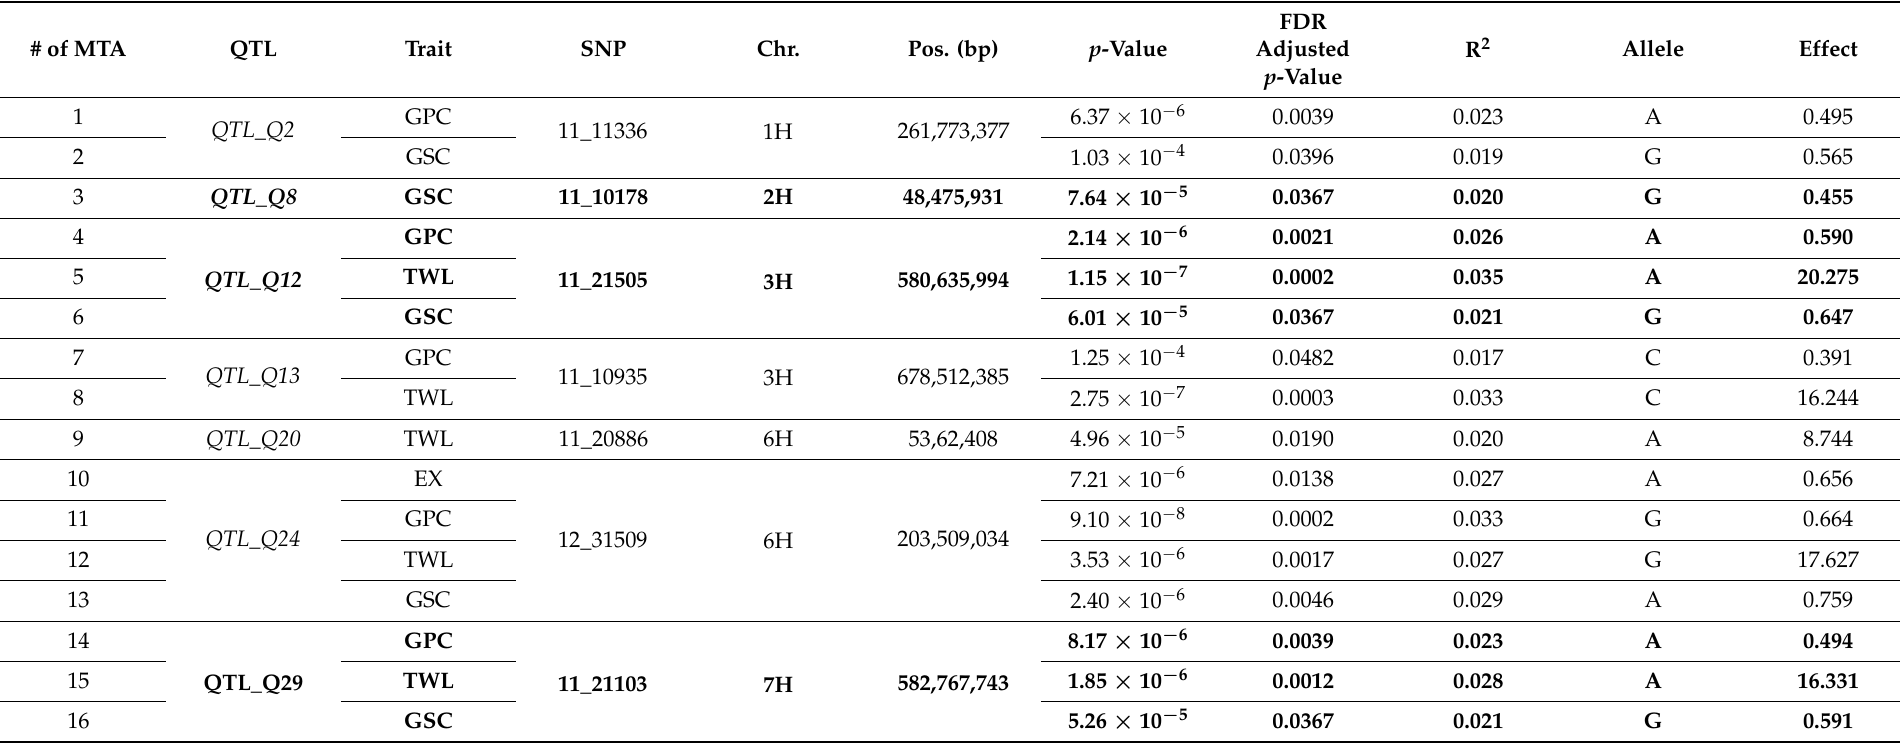
Table 3. List of significant marker–trait associations for grain quality traits. MTAs with p < 2.6 × 10 − 5 and FDR-adjusted p < 0.05 are listed. Novel QTLs are indicated in